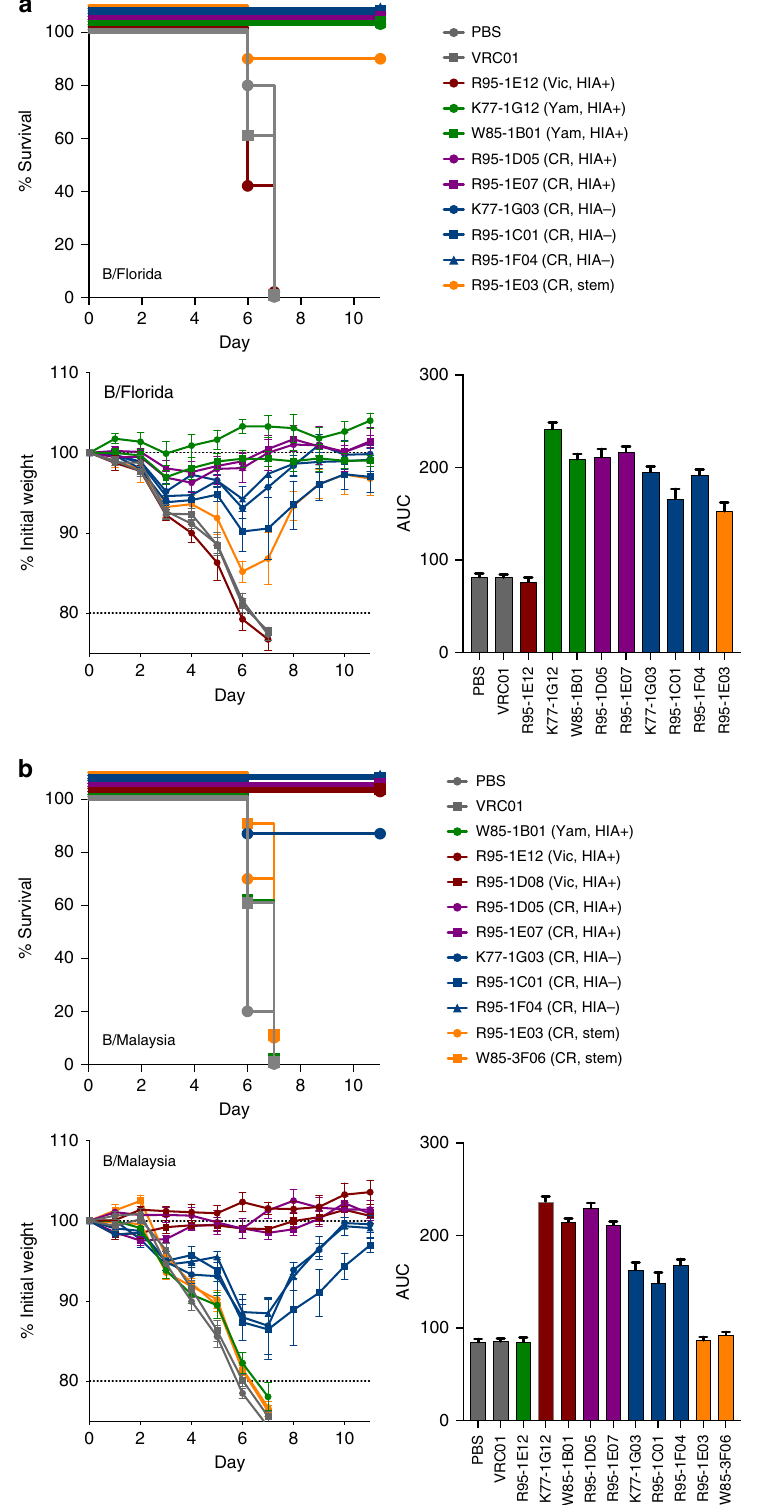
Fig. 4 Passive protection of mAbs in mice experimentally challenged with in fl uenza mice ( N = 5 per group) were infused with 5 mg/kg of anti-IBV mAbs or controls (PBS, VRC01) 24 h prior to intranasal challenge with a 50 TCID 50 B/Florida/4/2006 or b 2000 TCID 50 B/Malaysia/2506/2004. Survival curves (NB: lines are non-overlapping for clarity) and animal weights were monitored over an 11 day period, with animals killed if weight loss exceeded 20% of starting weight. Data is shown as mean ± SEM. Controls (grey), B/Yamagata-speci fi c (red), B/Victoria-speci fi c (green), cross-reactive HIA-positive (magenta), cross-reactive HIA-negative (blue) and cross-reactive stem mAbs (yellow) are indicated. The relative protection of each mAb assessed using area under the curve (AUC) analysis and plotted as mean ± SEM. Yam: B/Yamagata-speci fi c lineage, Vic: B/Victoria-speci fi c lineage, CR: cross-reactive, HIA + : showed HIA activity in vitro, HIA − : no HIA activity in vitro, stem: bound epitopes within the HA